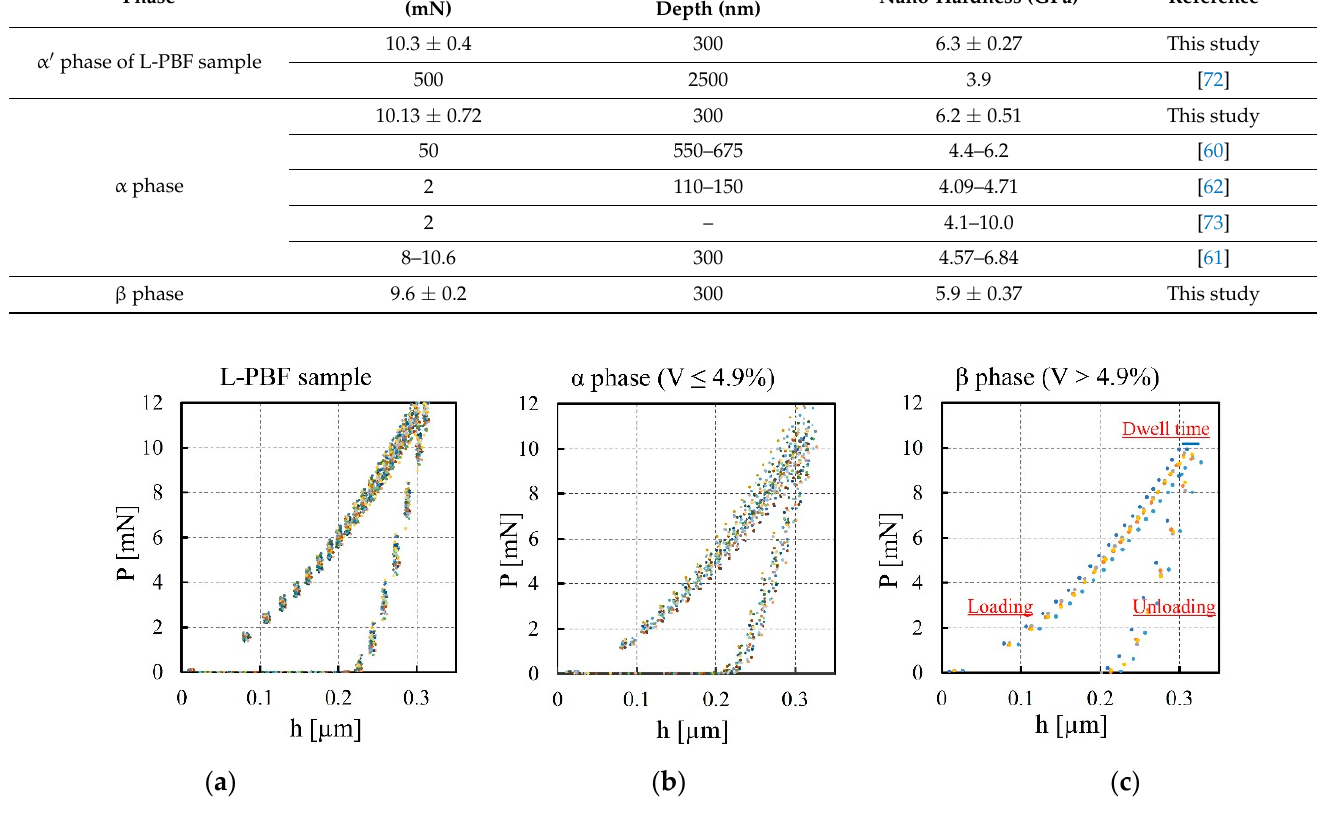
Figure 13. Loading and unloading indentations graphs of ( a ) L-PBF, ( b ) α phase-PM and ( c ) β phase -PM samples. Table 4. Nano-hardness of α ’, α , and β in L-PBF and PM samples.